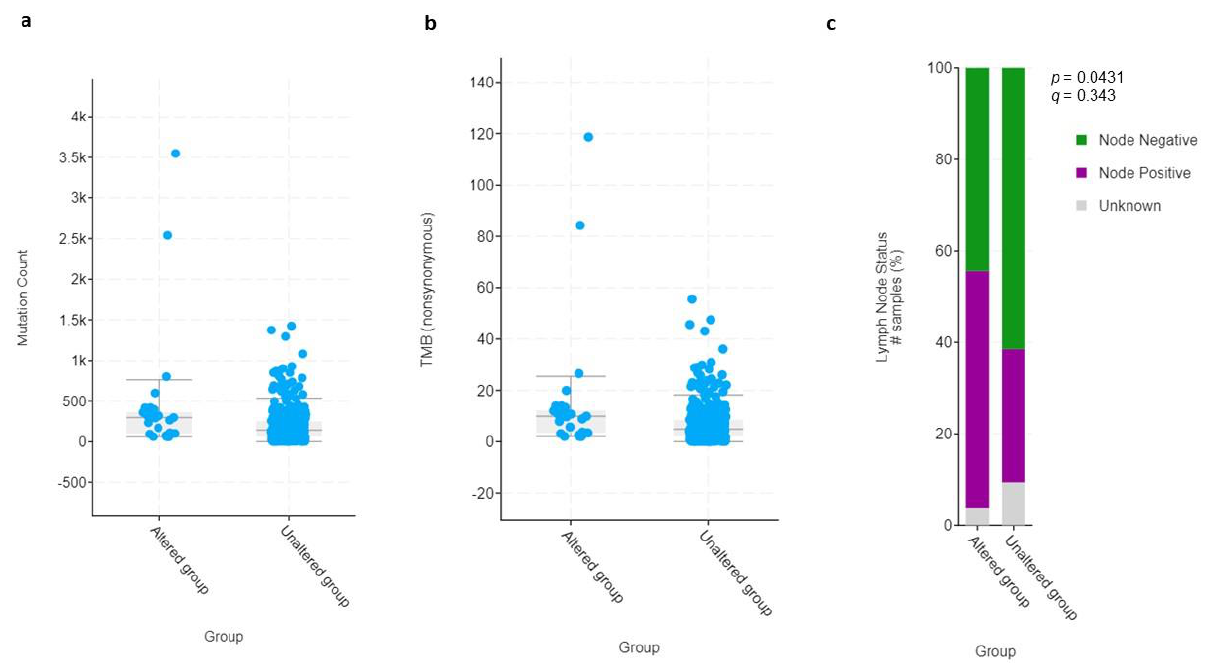
Figure 6. Dot plot graphs of ( a ) mutation count and ( b ) total mutational burden (TMB) of HIF-2- altered and unaltered tumors. ( c ) Bar graph of lymph node status of HIF-2-altered and unaltered tumors. # Number of samples (%).